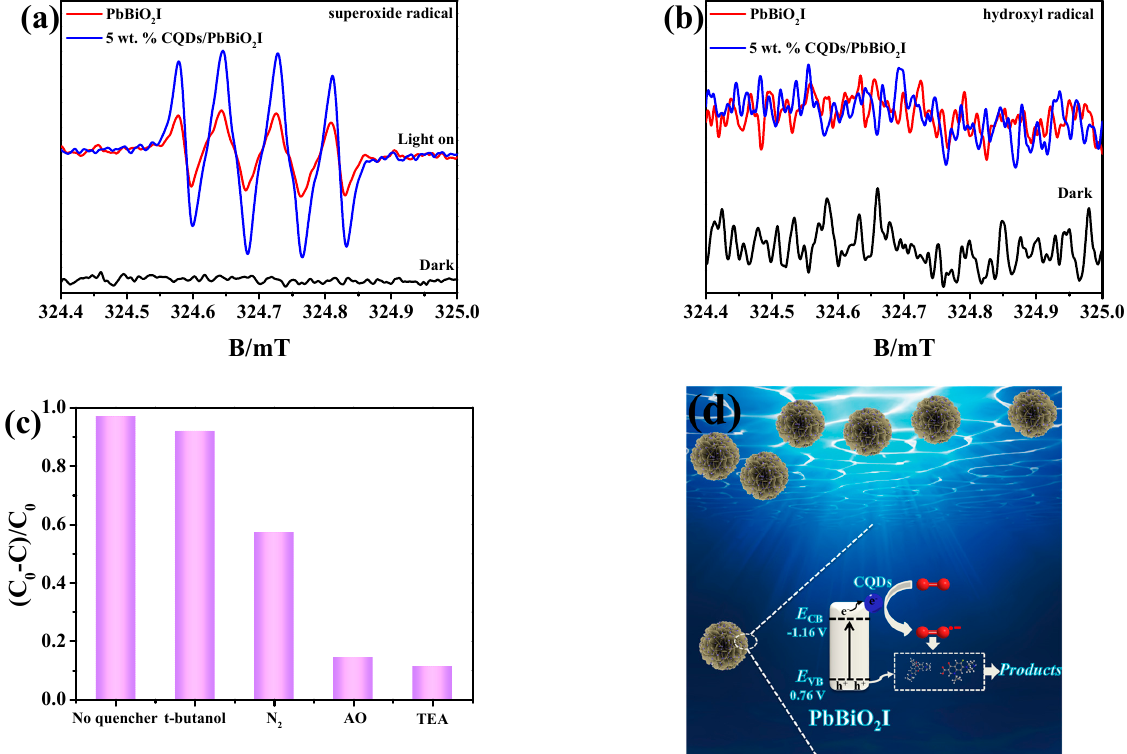
Figure 6. ( a ) DMPO- O 2• − and ( b ) DMPO-•OH of PbBiO 2 I and 5 wt.% CQDs/PbBiO 2 I; ( c ) trapping experiments of active species during the degradation of RhB; ( d ) photocatalytic mechanism of CQDs/PbBiO 2 I nanocomposite in photocatalytic degradation.